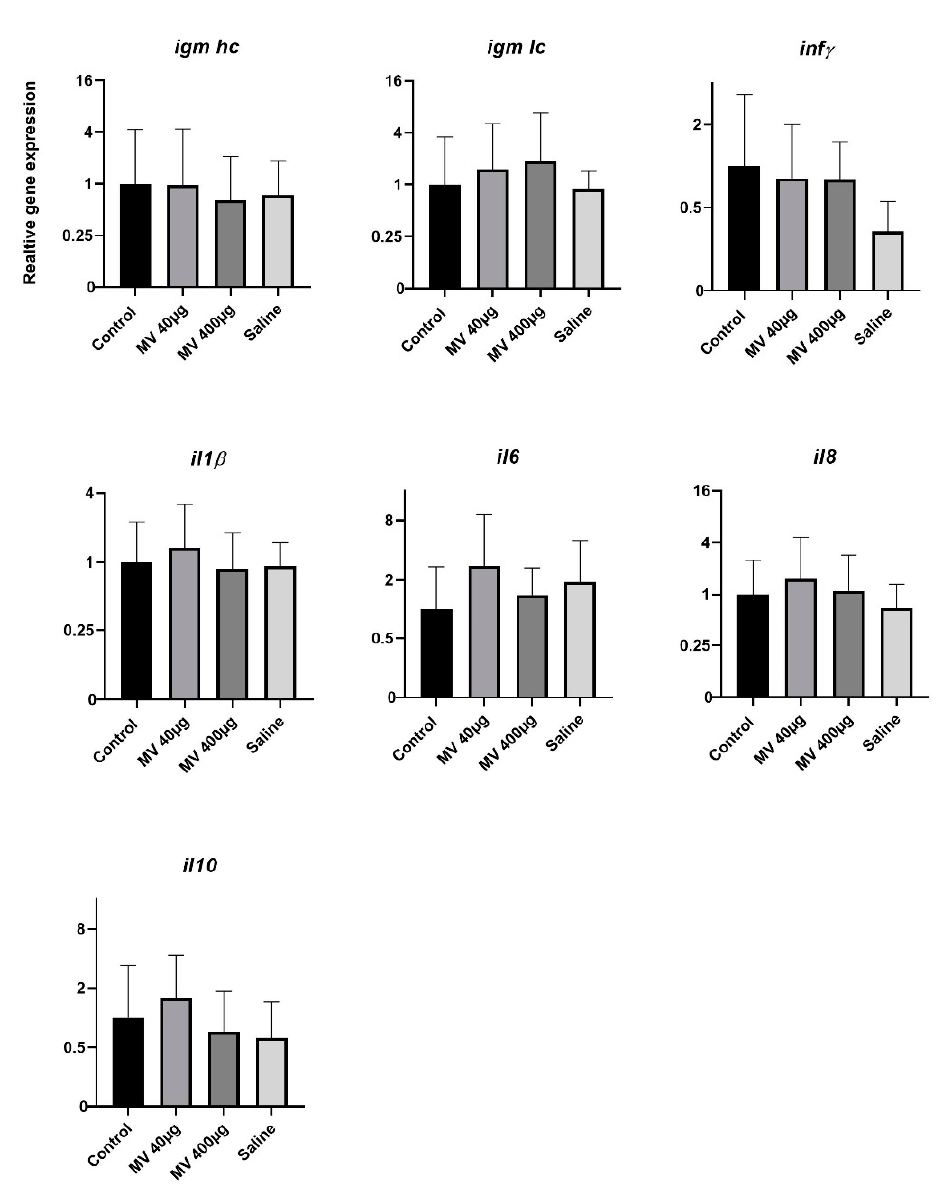
Figure A2. Immune genes with no significant differences in gene expression levels between the different treated groups during the toxicity trial in Atlantic cod. Gene expression level of different investigated genes were analyzed by qPCR and are displayed as relative gene expression. The gene expression levels were tested for significant differences in between the treatments ( p < 0.05; one-way ANOVA with multiple comparison using Tukey test; error bars indicate mean ± SEM).